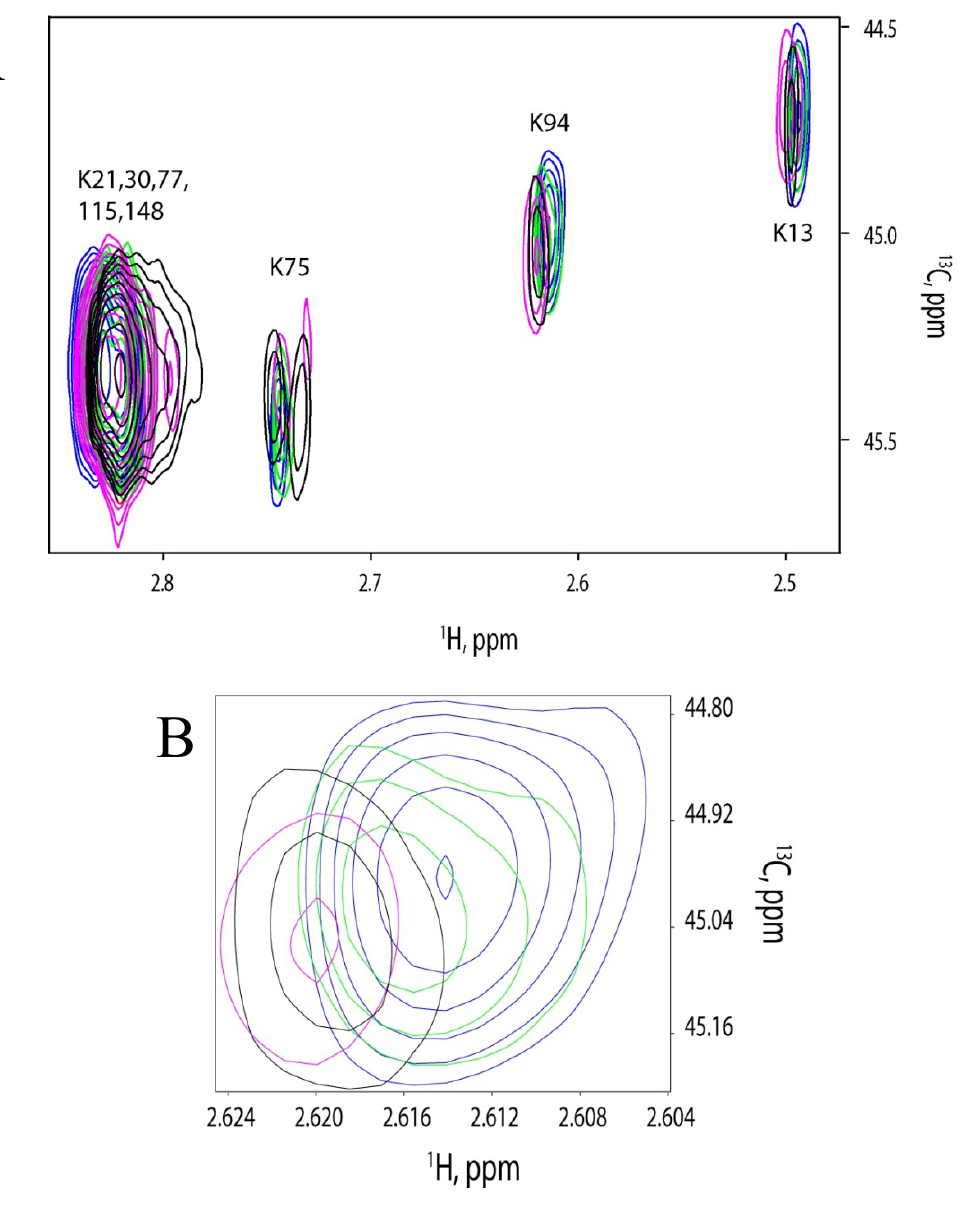
Figure 5. ( A ) NMR titration of different concentrations of FM-HVR into 1uM CaM. Titration ratios were 0:1 (blue), 0.5:1 (green), 1:1 (magenta) and 1.5:1 (black) of FM-HVR and CaM. ( B ) Magnified view of K94 residue showing saturation at 1:1 FM-HVR to CaM ratio. ( C ) NMR titration of different concentrations of FM-HVR into 70uM CaM. FM-HVR concentrations were varied to achieve 0:1 (blue), 1:1 (green), 2:1 (magenta) and 3:1 (black) molar ratios to CaM. ( D ) Magnified view of K75 residue showing saturation at 2:1 FM-HVR to CaM